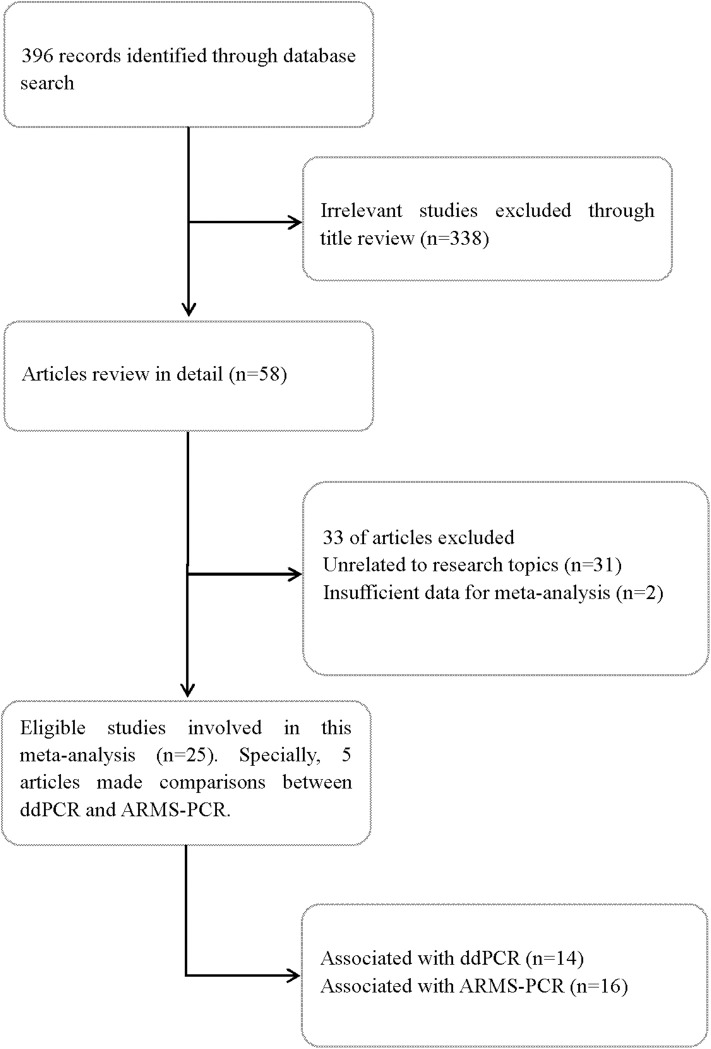
Flow diagram detailing the search strategy of the included studies in this meta-analysis.